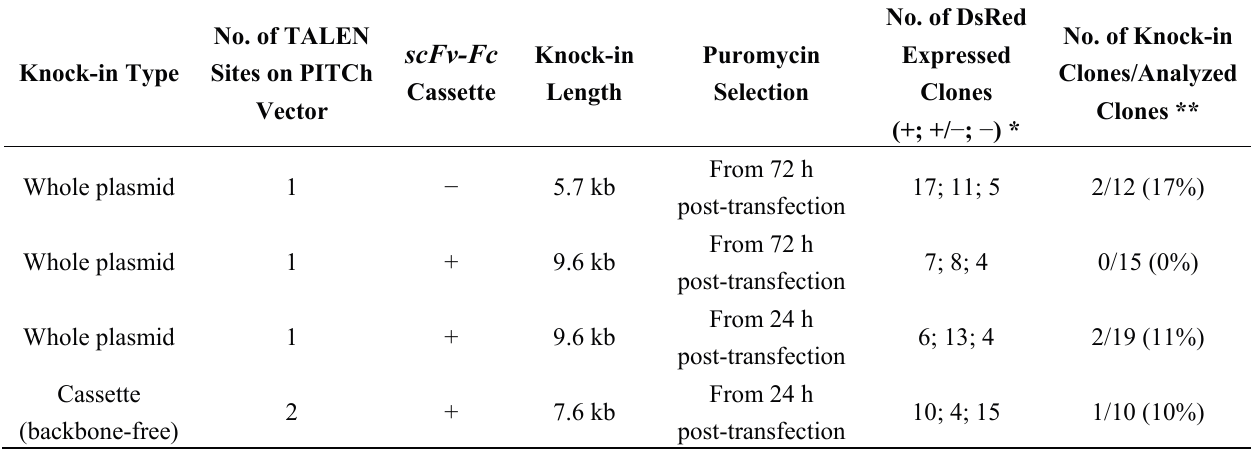
Table 1. Summary of gene knock-in at the HPRT1 locus in CHO-K1